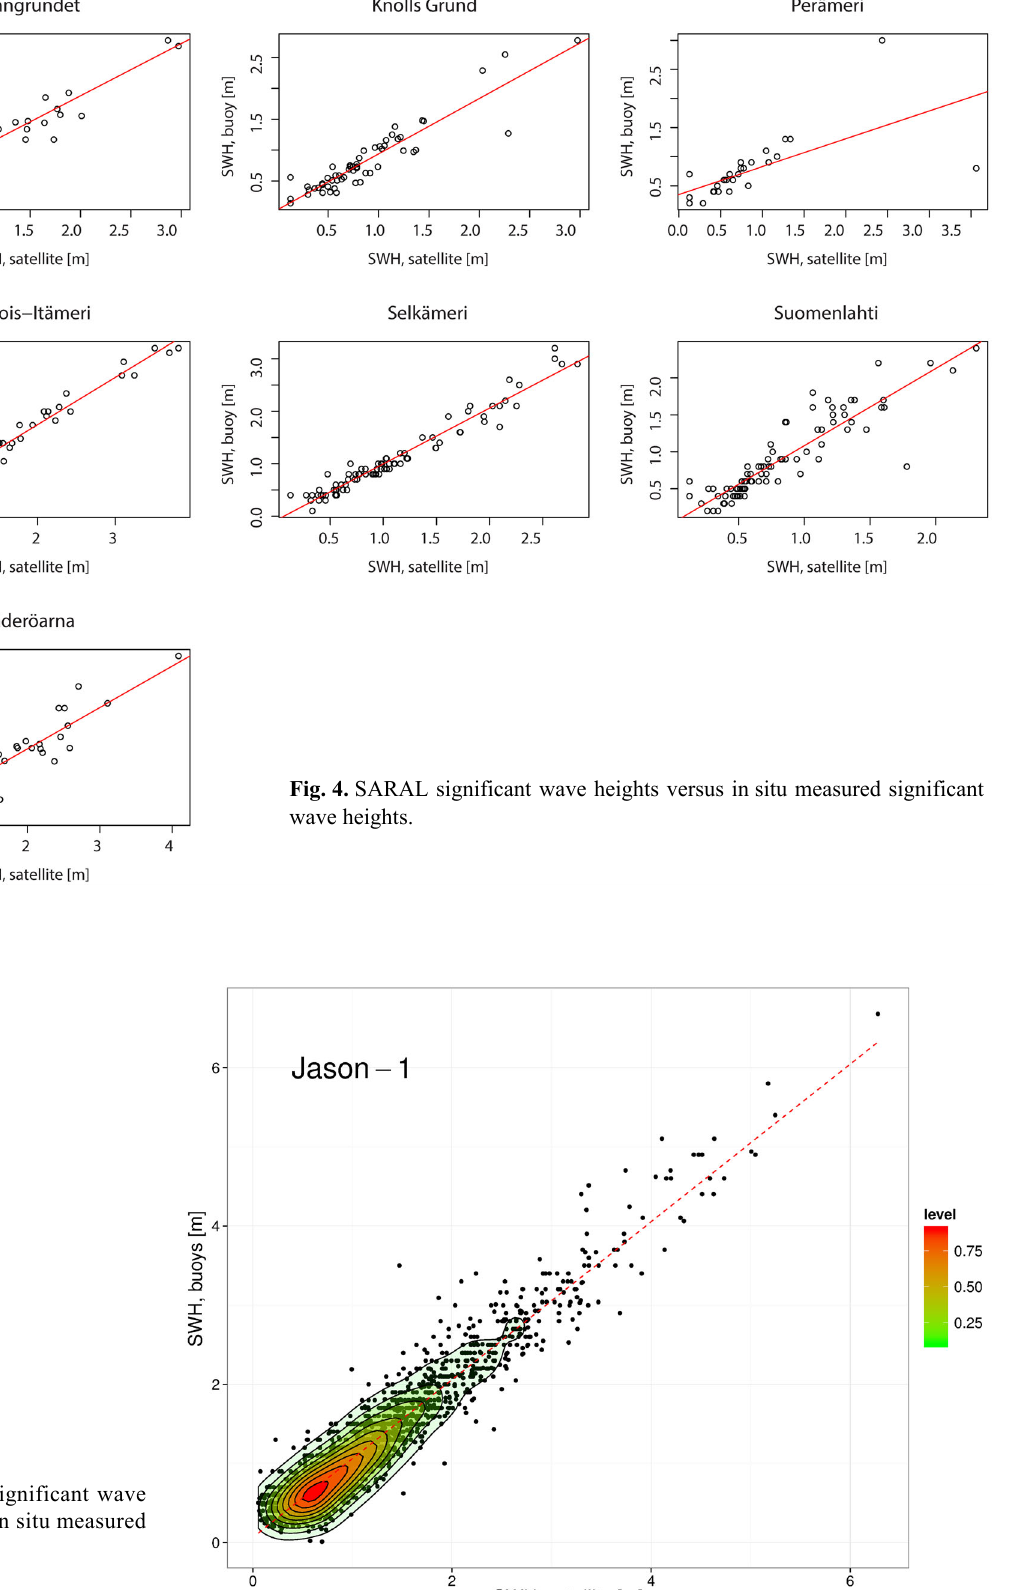
Fig. 5. JASON-1 significant wave heights versus all in situ measured wave